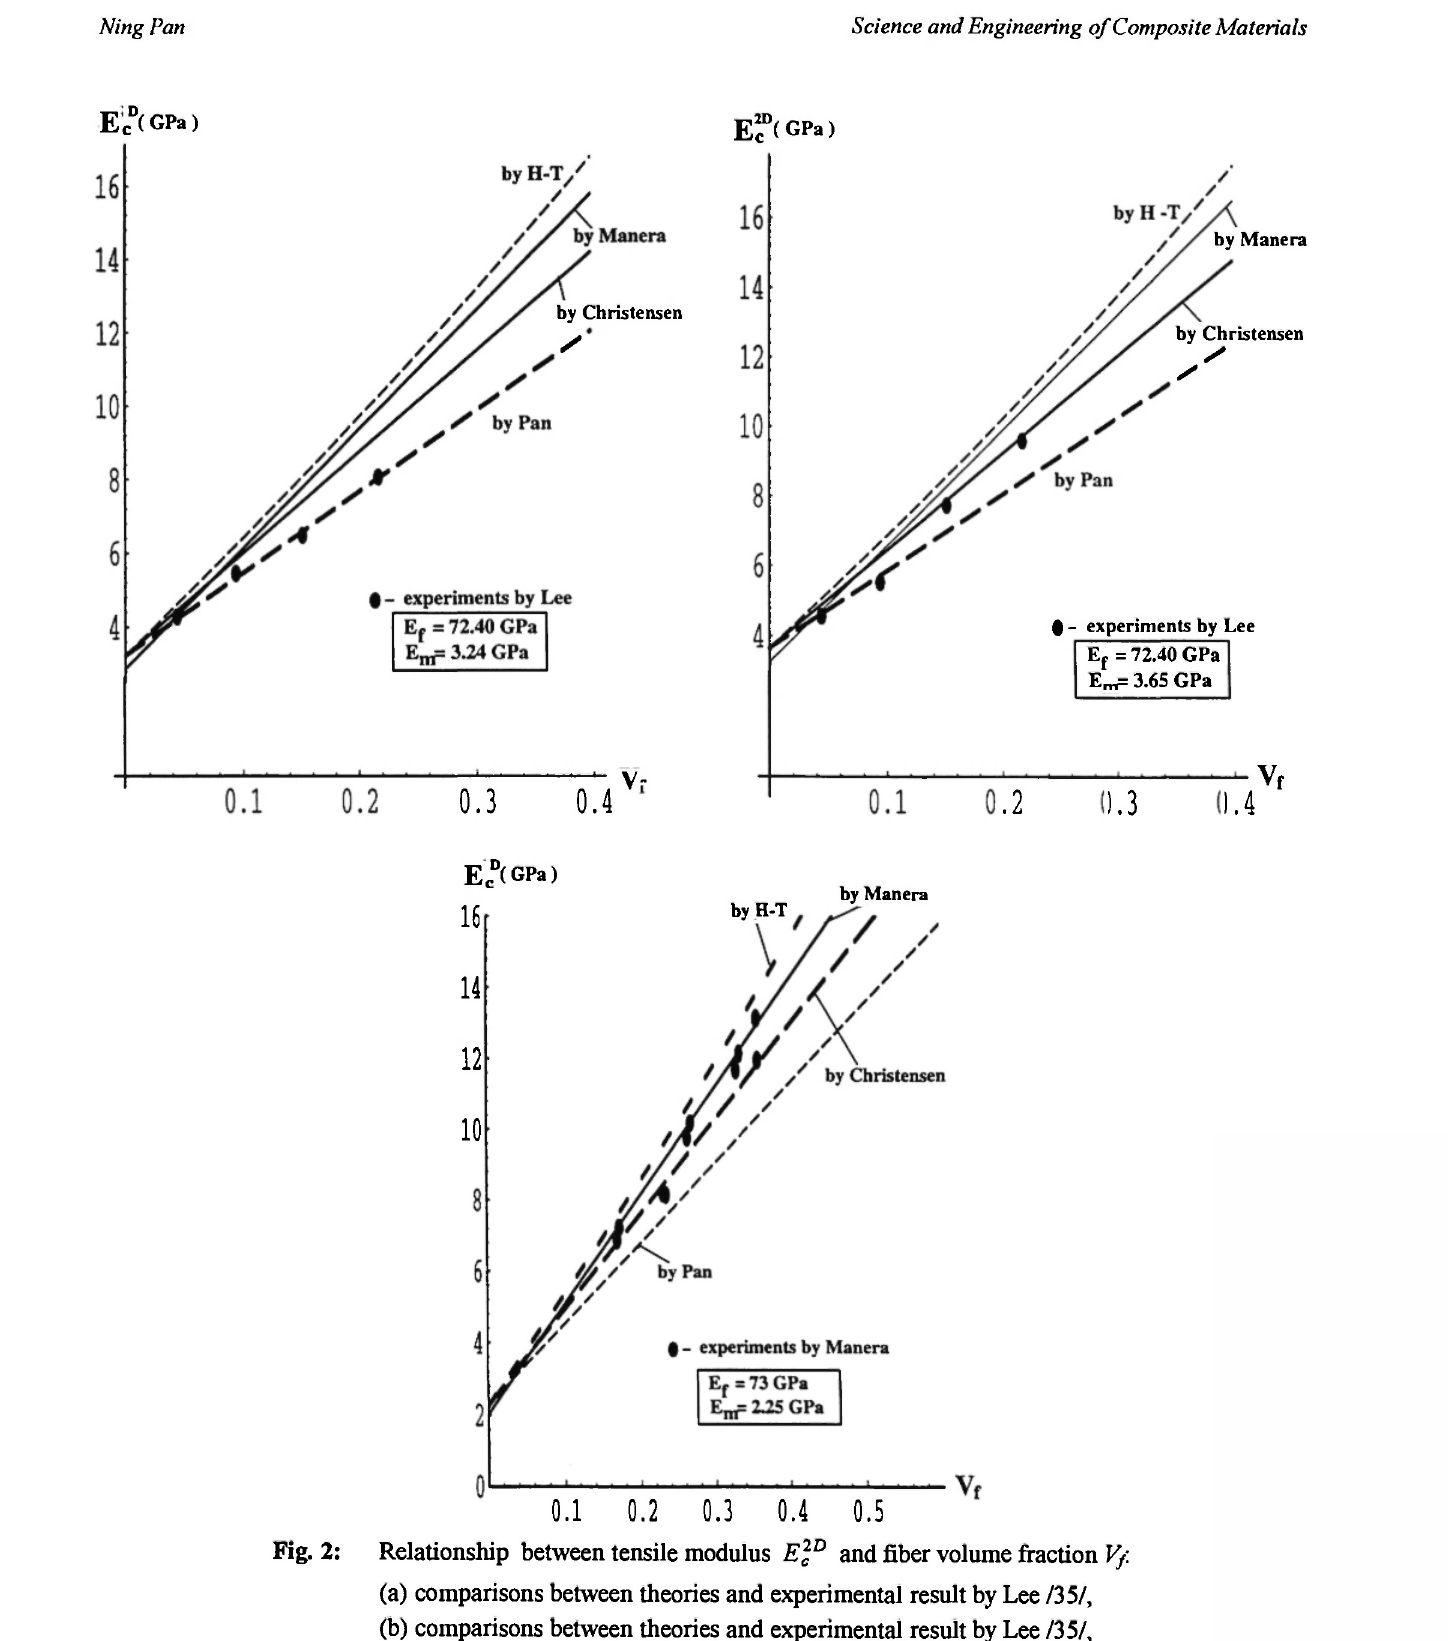
Fig. 2: Relationship between tensile modulus E 2 CD and fiber volume fraction Vf. (a) comparisons between theories and experimental result by Lee /35/, (b) comparisons between theories and experimental result by Lee /35/, (c) comparisons between theories and experimental result by Manera